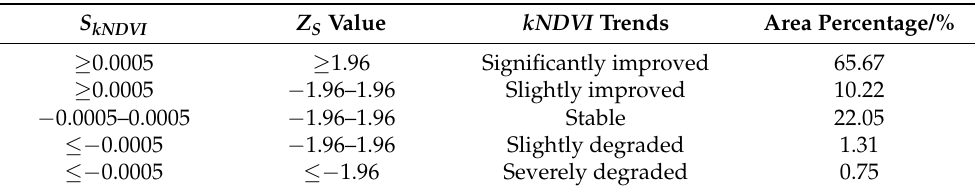
Table 2. Statistical analysis results of kNDVI trends.